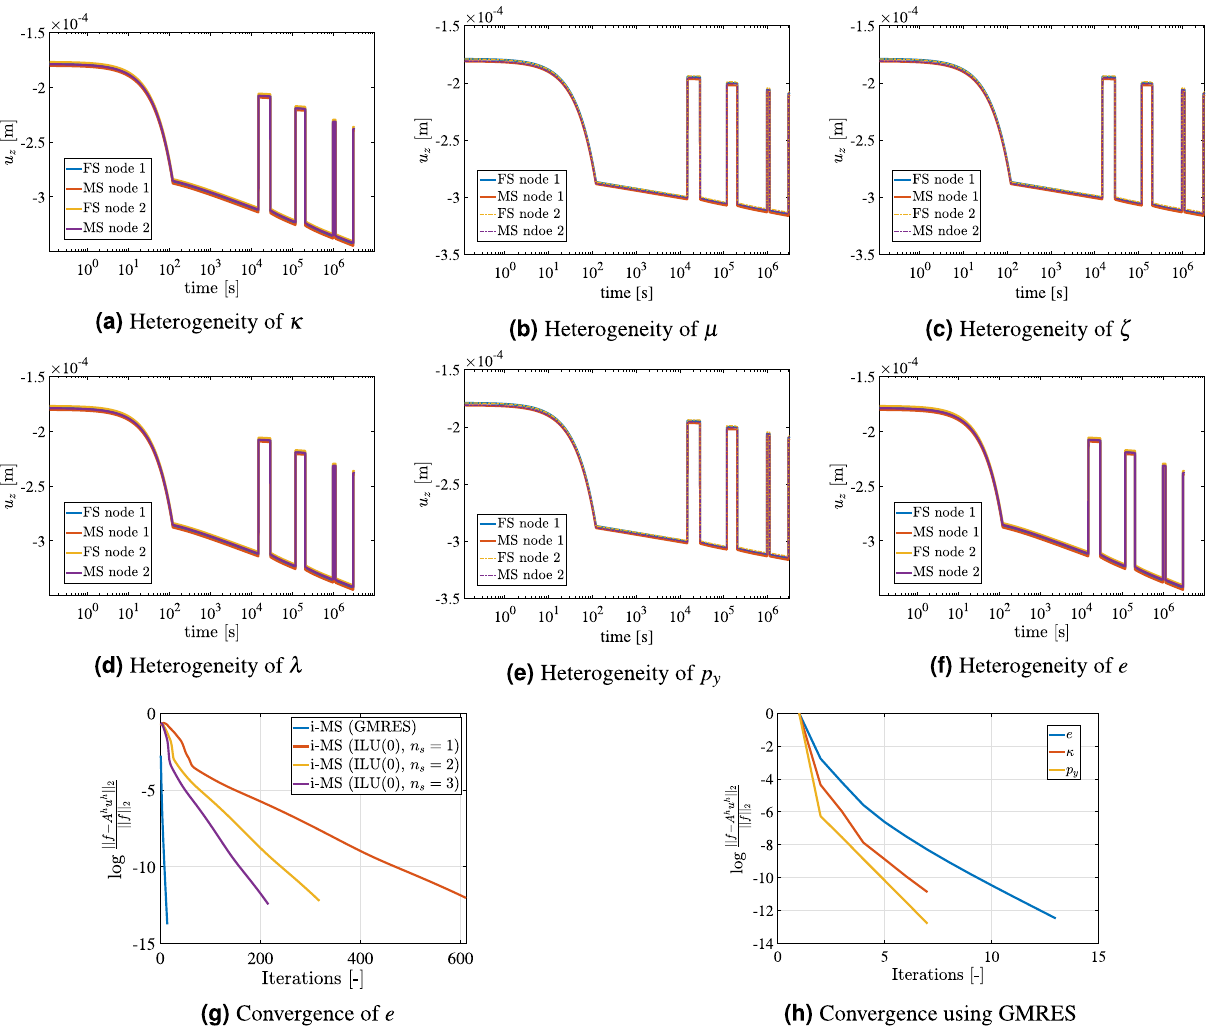
Figure 8. Heterogeneity: illustration of the impact of heterogeneity in shale properties on the axial deformation. The chosen parameters and its range is shown in Table 3. Heterogeneity in κ , µ , ζ , (cid:31) , p y and e is shown in the Fig. 8 (a – f) , respectively. The convergence plot for void ratio is shown in Fig. 8 (g) and the convergence plot for different parameter using GMRES is shown in Fig. 8 (h)